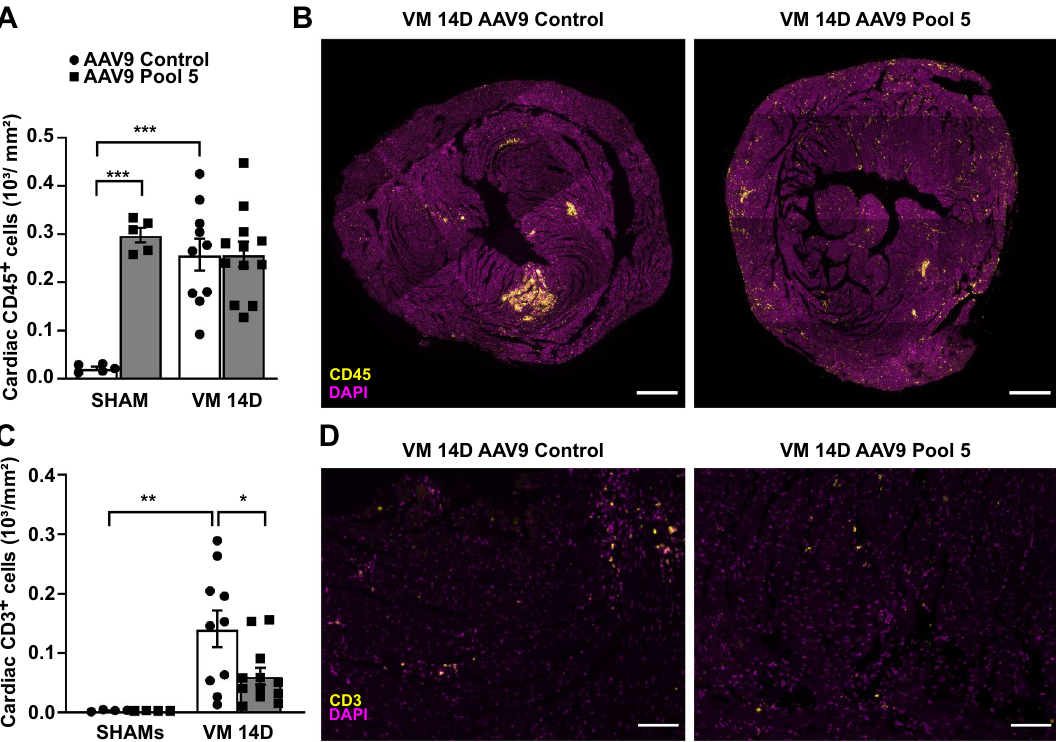
Figure 3. Overexpression of IL9 plus IL3, IL4, IL13, IL15 (Pool 5) decreases T lymphocyte response in the acute phase. ( A , B ) CD45 staining (yellow patches, leukocytes) at 14 days post-infection in Pool 5-overexpressing hearts and controls. Scale bar = 500 µm. Significance assessed by two-way ANOVA followed by Tukey’s test with ***p ≤ 0.001. ( C , D ) CD3 + staining (T lymphocytes) 14 days after CVB3 infection in Pool 5-overexpressing hearts and controls. Scale bar = 100 µm. Significance assessed by two-way ANOVA followed by Tukey’s test with *p ≤ 0.05; **p ≤ 0.01. All values are expressed as mean ±